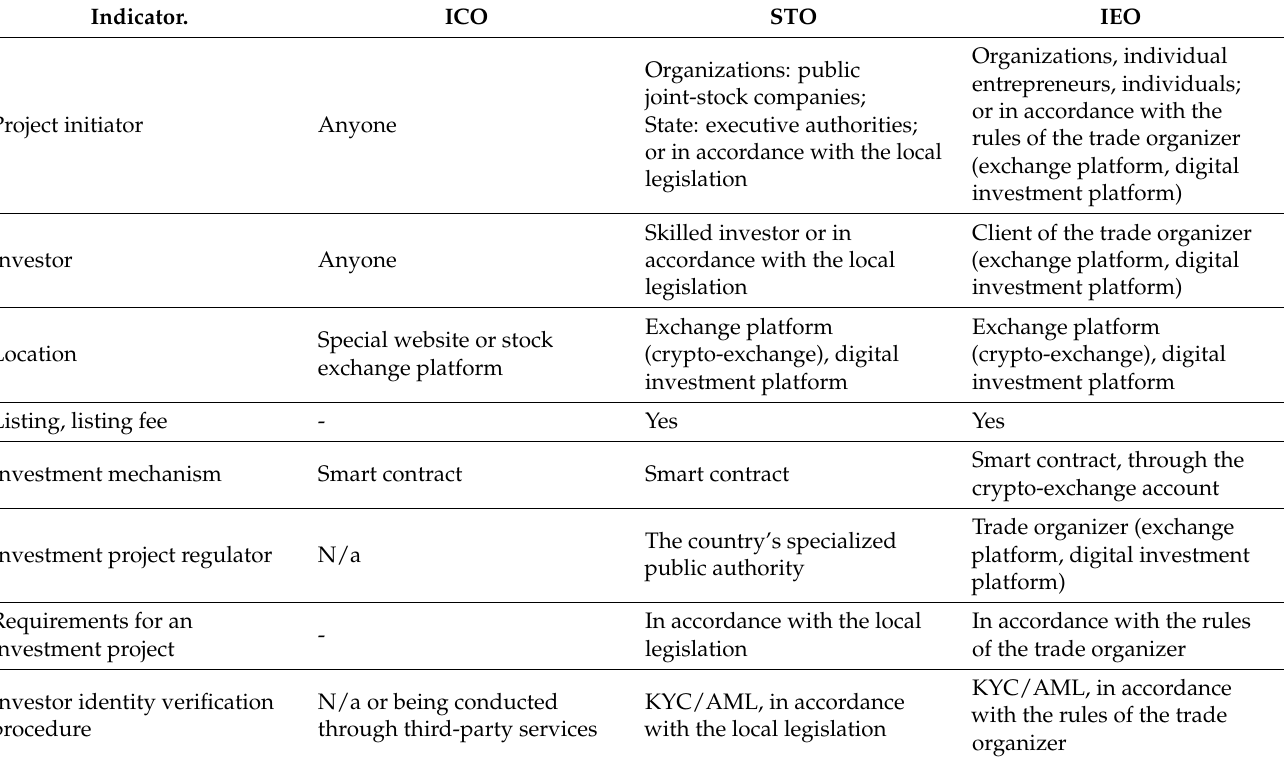
Table 6. Comparative characteristics of ICO, STO, and